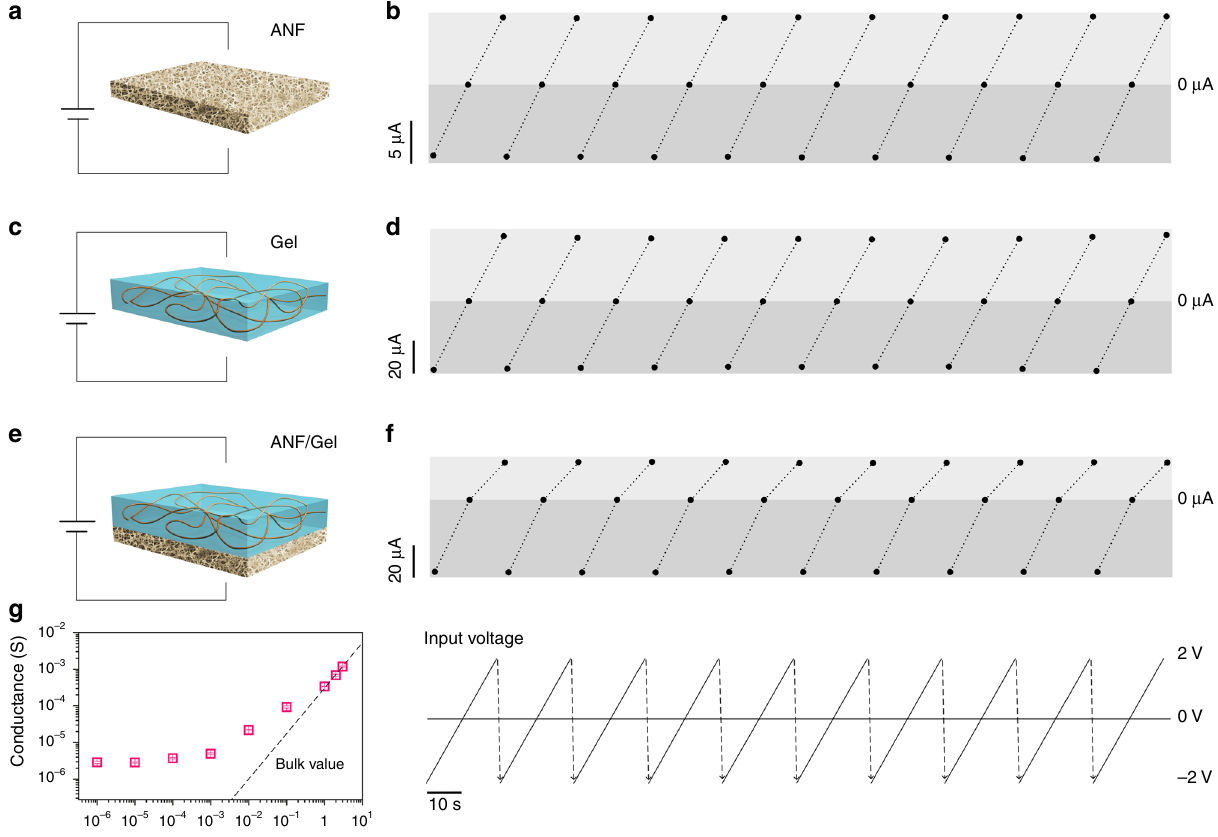
Fig. 3 Charge-governed asymmetric ion transport. a , b I – V curves of the separate ANF membrane under a symmetric voltage of ±2 V. c , d I – V curves of the separate polyelectrolyte gel membrane under a symmetric voltage of ±2 V. e , f I – V curves of the heterogeneous membrane under a symmetric voltage of ±2 V. The cathode is placed in the ANF side and the testing electrolyte solutions for the above three conditions are all 0.01 M KCl (pH ~ 7). g The transmembrane ionic conductance deviates remarkably from the bulk value (dashed line) when the electrolyte concentration is <0.1 M, indicating a charge- governed ionic transport. Error bars represent SD ( n =